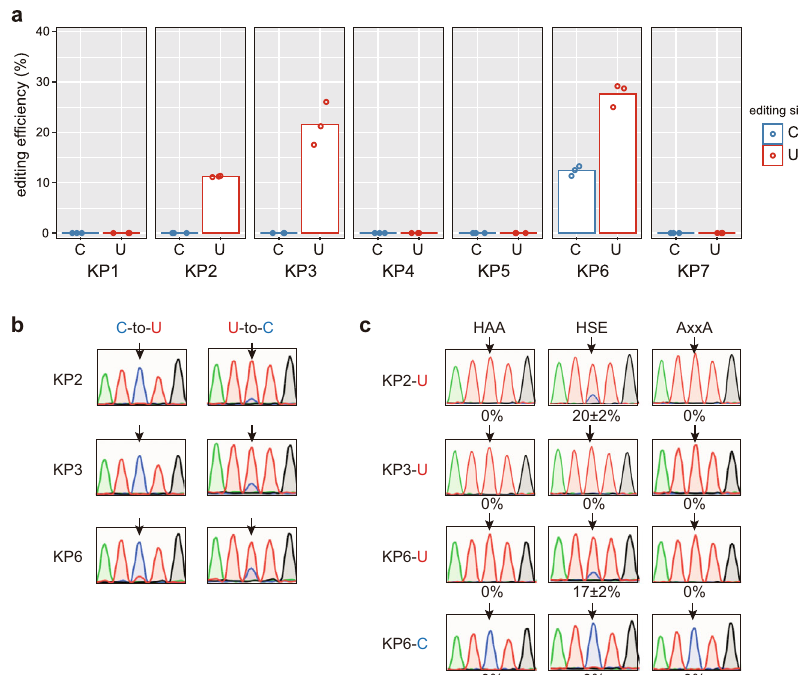
Fig. 4 KP2 and 3 exert U-to-C editing activity, whereas KP6 has both C-to-U and U-to-C editing activities in human cells. a The C-to-U (C) and U-to-C (U) editing ef fi ciencies of seven DYW:KP proteins are given as the mean (bar) of three biologically independent replicates (dots). The chromatograms for one replicate are shown in ( b ). c The C-to-U and U-to-C editing activities depend on the DYW:KP domain. The editing ef fi ciencies of DYW:KP mutants are given as the mean ± s.d. of three biologically independent replicates. The chromatogram of one replicate is provided as an example. Arrows indicate the editing